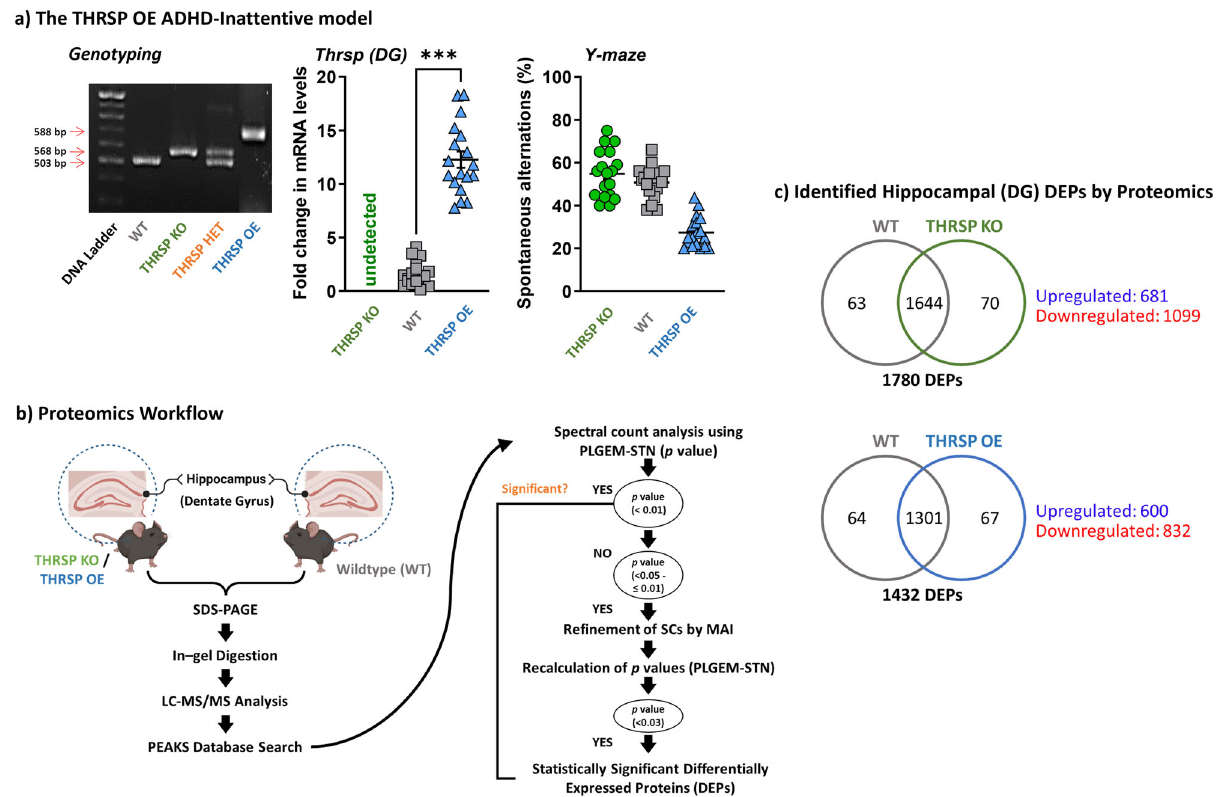
Fig. 1 Proteomics work fl ow in THRSP transgenic mice. a Con fi rmation of transgenic backgrounds in mice was performed via DNA electrophoresis (Genotyping) and qRT-PCR (Thrsp mRNA expression) analyses ( n = 18 mice/group, two-tailed, paired t test: ( t = 11.9, df = 17, P < 0.001)). Thrsp mRNA was not detected in THRSP KO mice. Subsequently, mice were exposed to the Y-maze test to recon fi rm inattention in THRSP OE mice when compared to WT and THRSP KO mice ( n = 18 mice/group: one-way ANOVA, F ( 2, 51 ) = 51.7, P < 0.001). THRSP OE mice show sustained inattention and memory impairments. Values are presented as the mean ± standard error of the mean (SEM). b Following the con fi rmation of behavior in mice, hippocampal DG were prepared for subsequent proteomics analysis. c Summary of identi fi ed DEPs in mouse hippocampal DG. THRSP/Thrsp thyroid hormone-responsive protein, OE overexpressing, DG dentate gyrus, DEPs differentially expressed proteins. The images used in ( b ) was created with